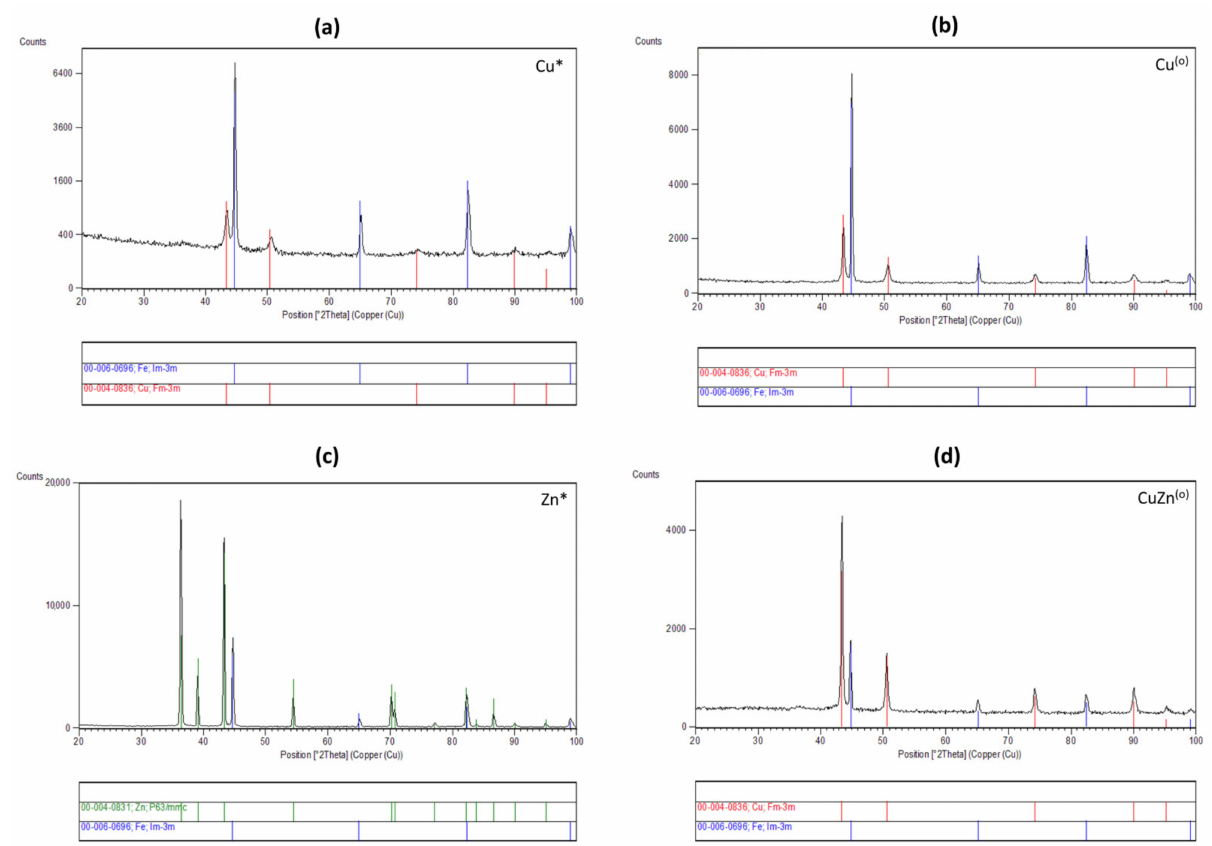
Figure 13. The X-ray diffraction patterns of: ( a ) fine-grained copper coating; ( b ) olive-like copper coating; ( c ) fine-grained zinc coating; ( d ) olive-like structured CuZn coating (4 at. % of Zn). *—fine-grained structure; (o) —olive-like structure.